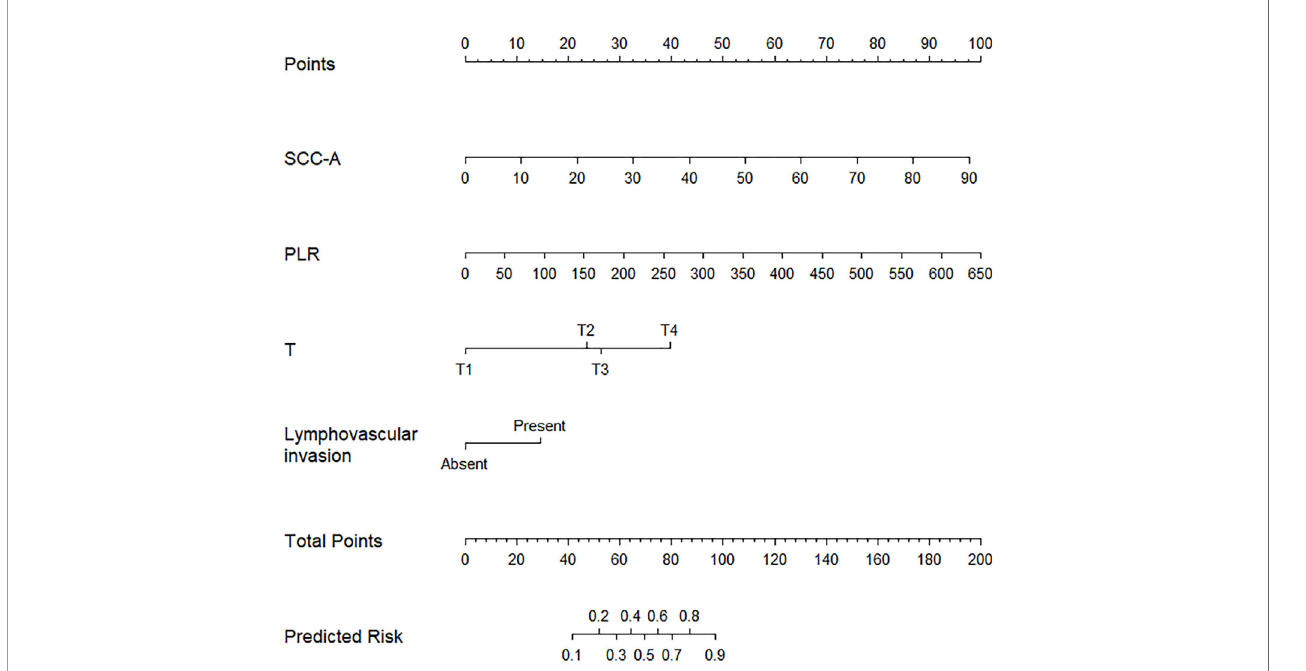
FIGURE 2 | Predicted nomogram for PCCS patients: a line was drawn straight down to predict the risk of ENE. T, Pathology T stage; PLR, platelet-lymphocyte ratio; SCC-Ag, Squamous cell carcinoma antigen.